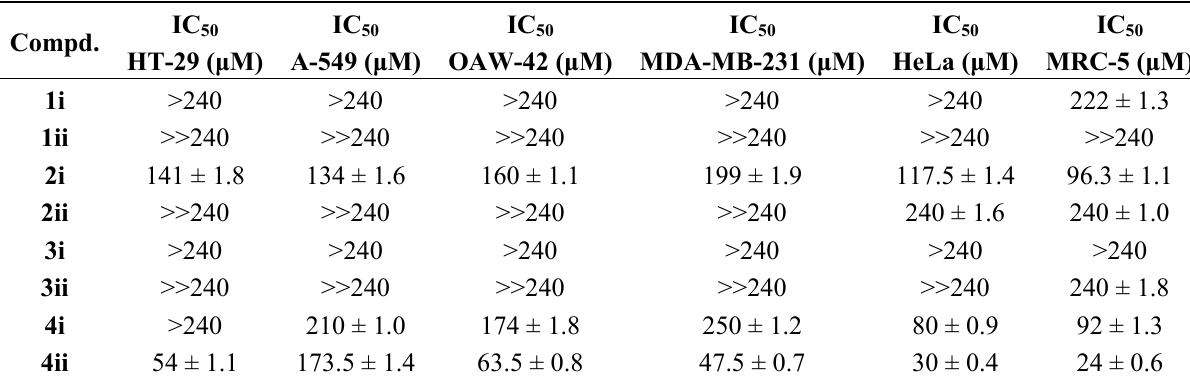
Table 4. Anticancer activity of cinnamic acids 1 – 4 . IC compounds (in μ M) required for 50% growth inhibition of human cancer cells of several types. MRC-5 refers to normal